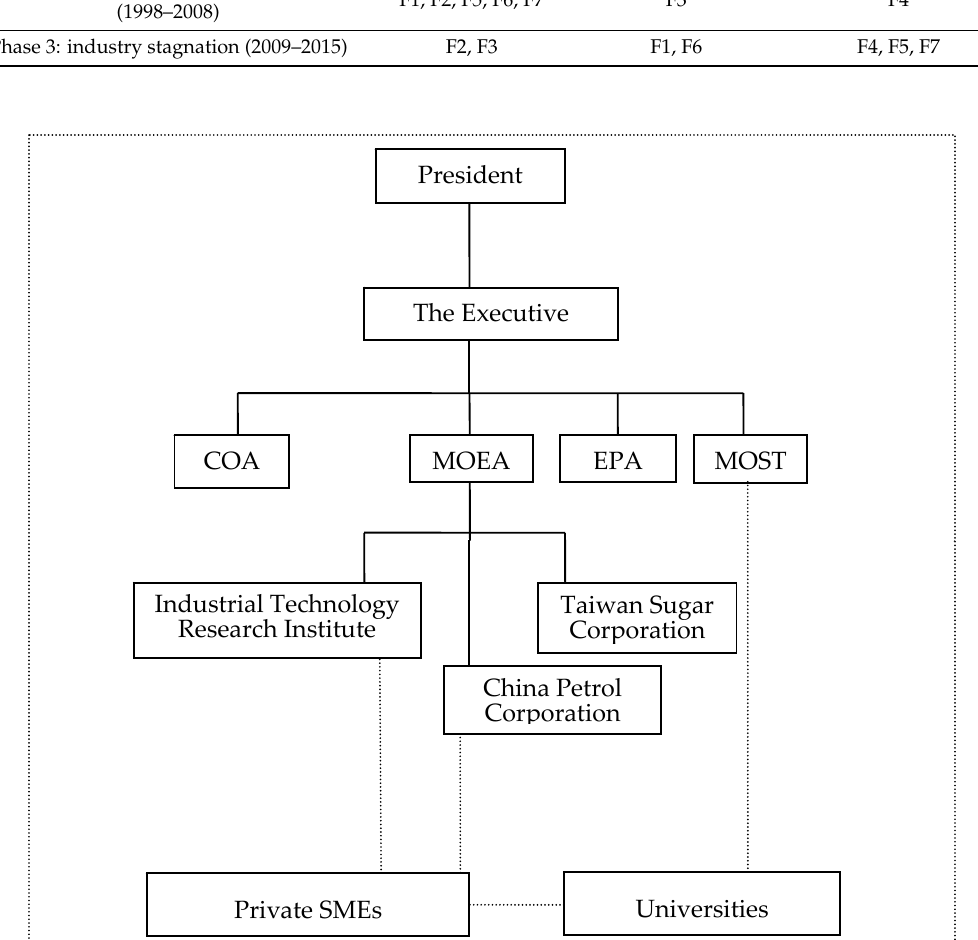
Figure 1. Institutions of the executive branch in Taiwan. Abbreviation: MOST = Ministry of Science and Technology (NSC = National Science Council), MOEA = the Ministry of Economic Affairs, COA = the Council of Agriculture, EPA=Environmental Protection Administration.